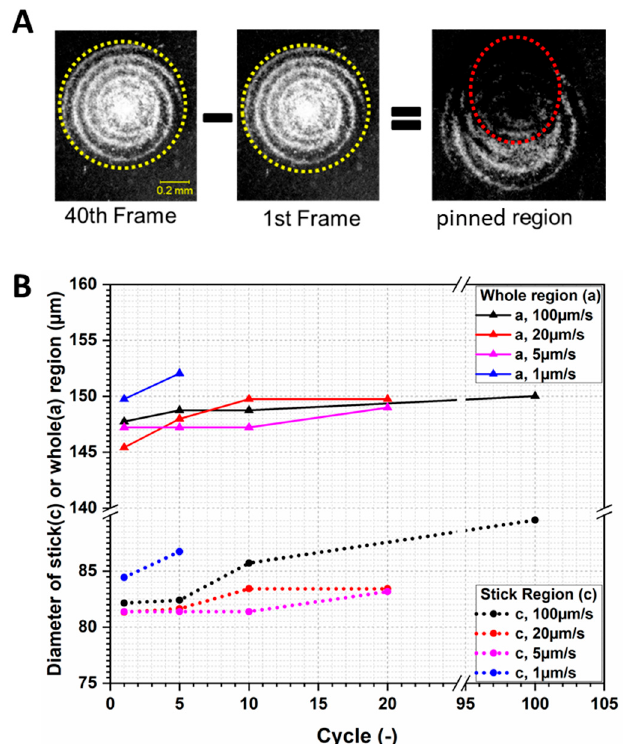
Figure 8. ( A ) The area of the pinned region was calculated by subtracting the 1st frame from the 40th; identical features are assumed to be pinned to the countersurface. ( B ) Change of pinned and slipping regions with cycles.